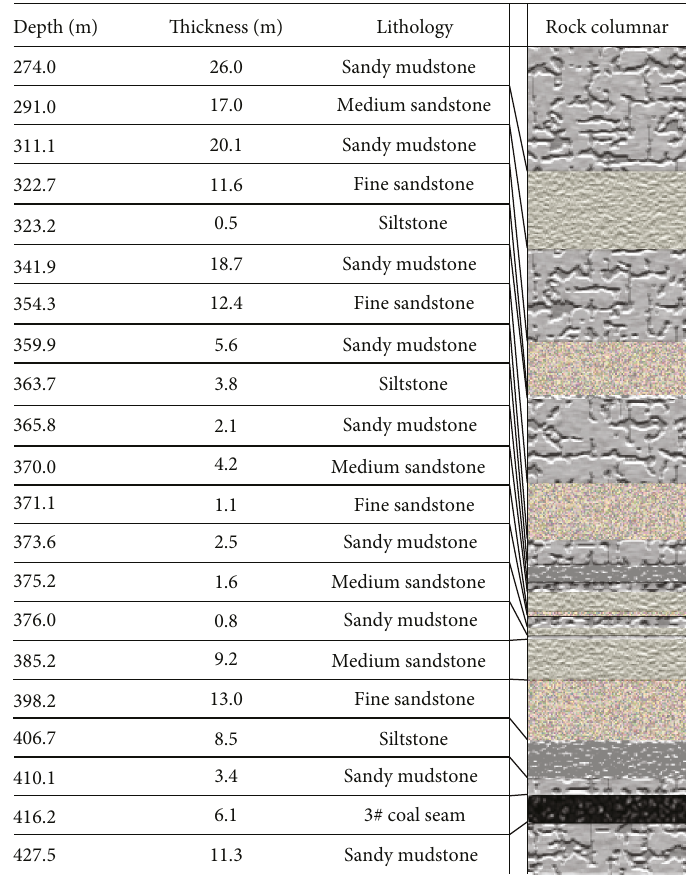
Figure 2: Stratigraphic column of the studied